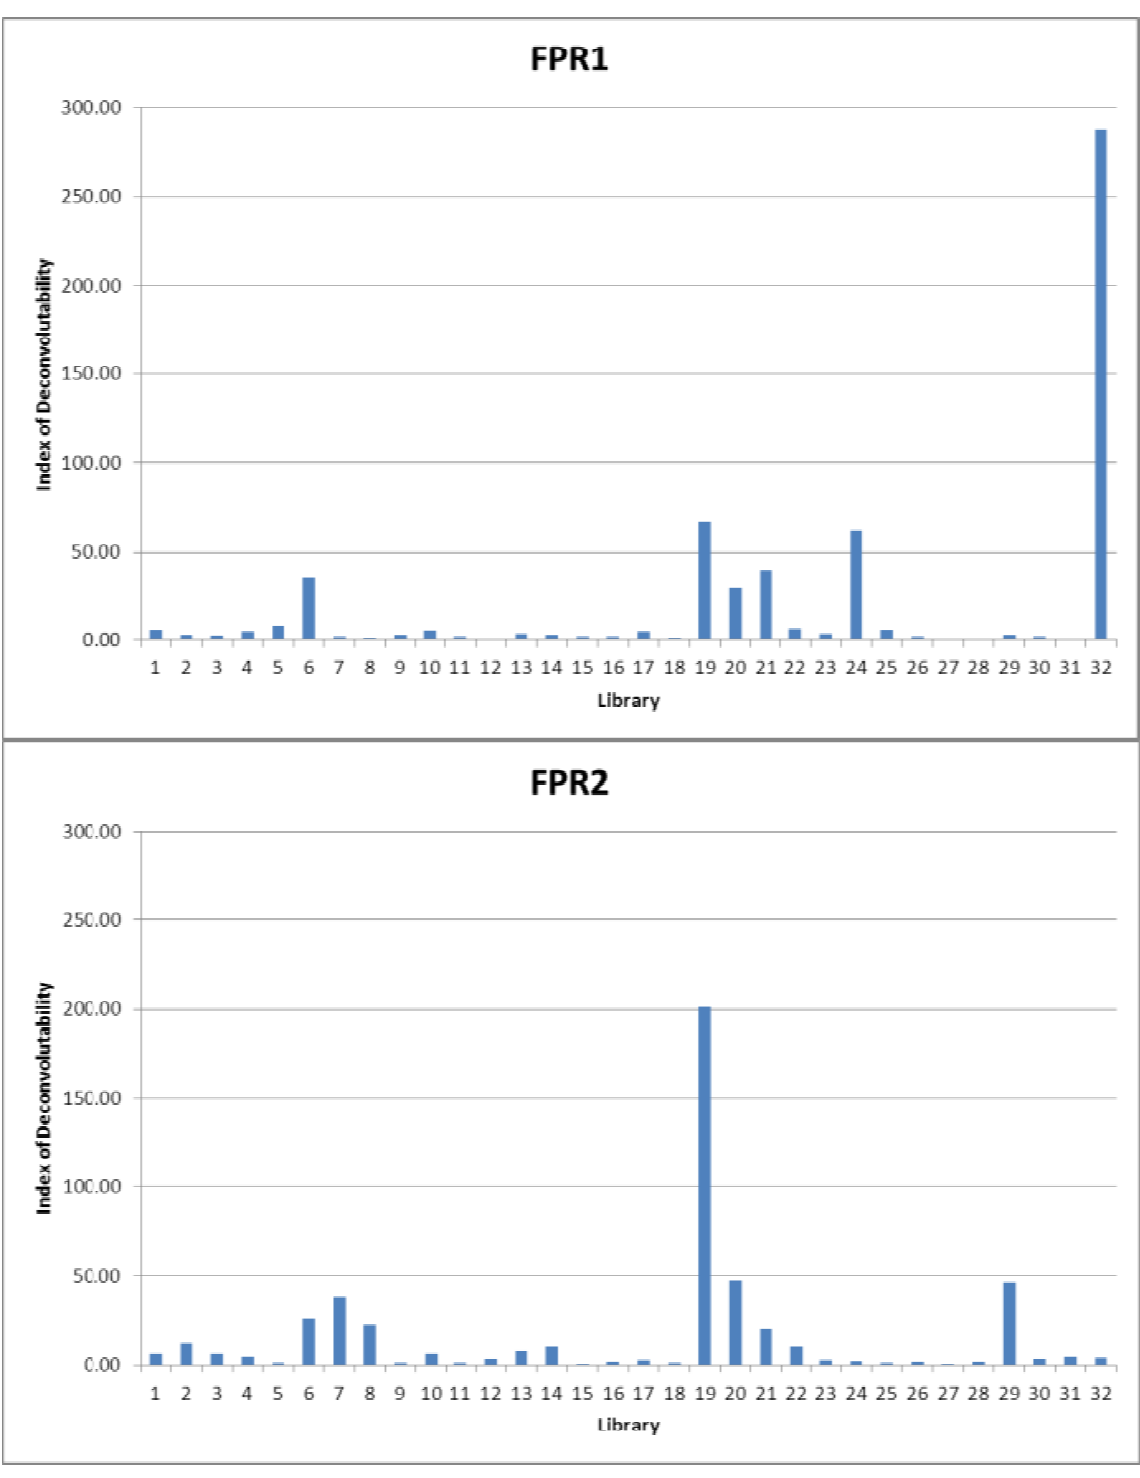
Figure 5. Indices of Deconvolutability for each library, as defined in Equation (6), against both